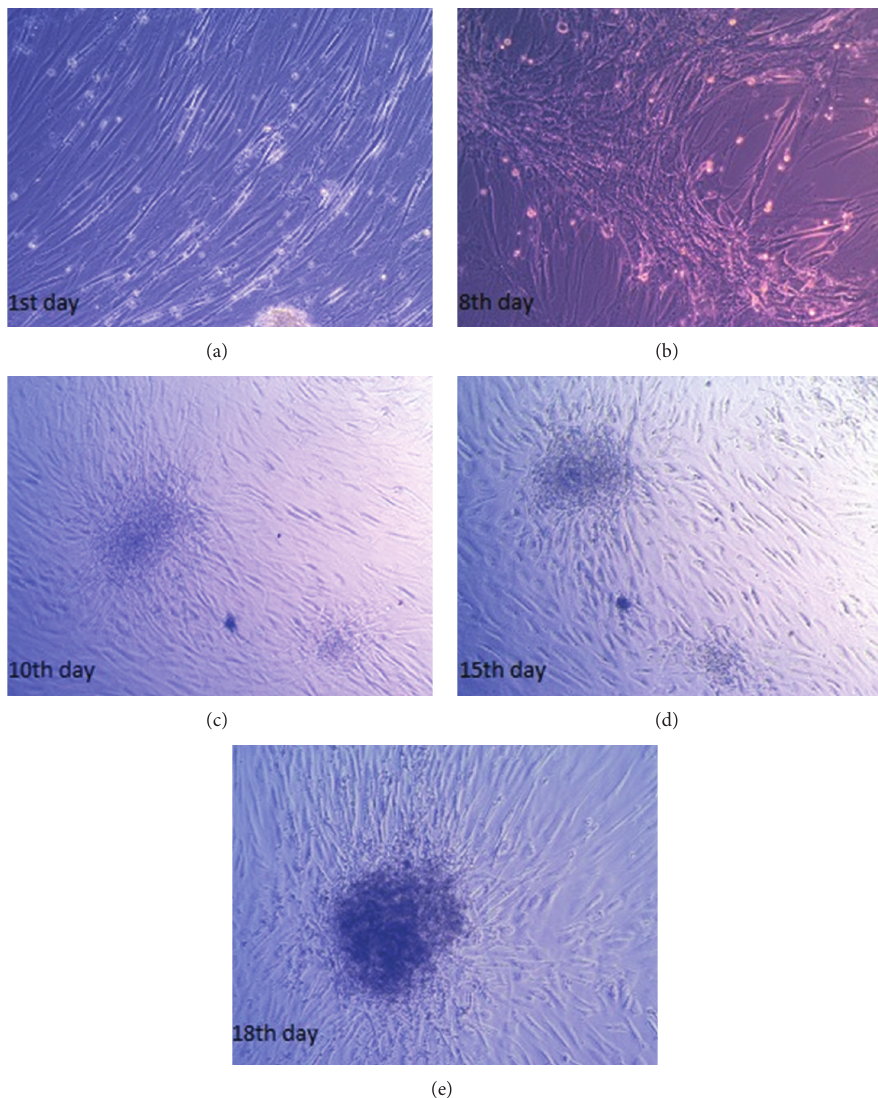
Figure 3: Morphological changes of mesenchymal stem cells during 18 days of differentiation. When observed under an inversed microscope, undifferentiated MSCs looked like long spindle-shaped fibroblastic cells and cultures showed a confluency (1st day). Some cells did not change their morphology during 18 days of differentiation, but many of them migrated (8th day). Cells aggregated in clusters and formed islet-like structures (10th day). Cells created colonies from 10th day and continued to 18th day ( × 40